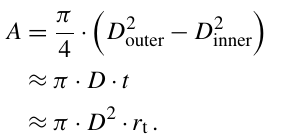
Table 1. Cost fractions after Jamieson (2018) and resulting cost- per-mass factors.